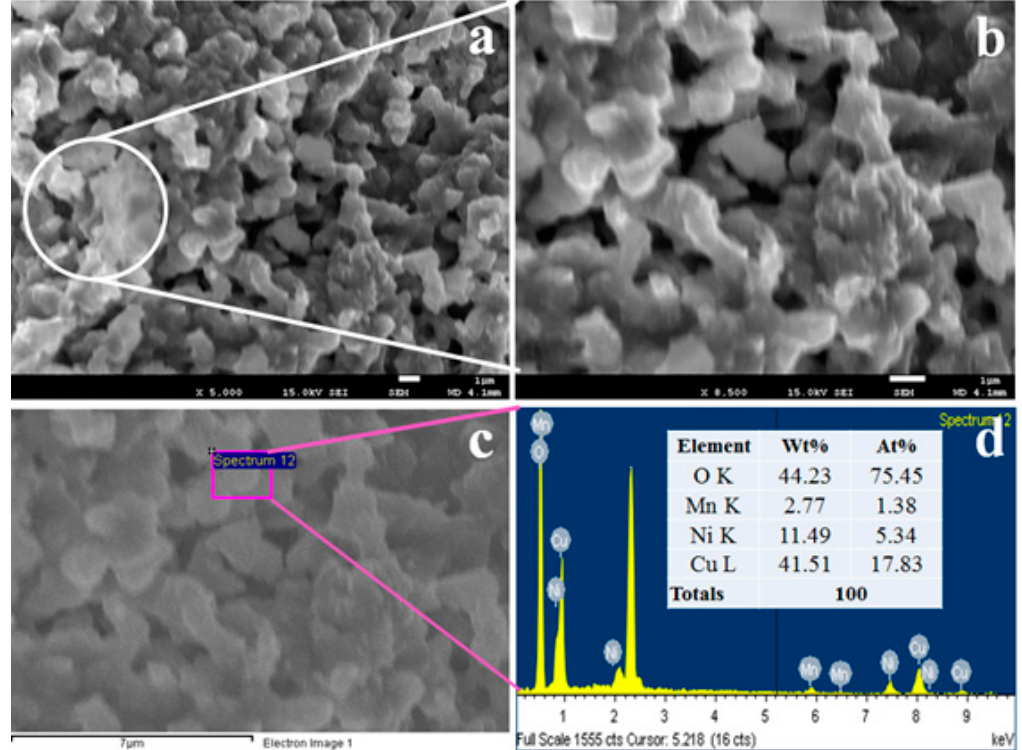
Figure 2. The FESEM and EDS analyses of CMNO nanomaterials. ( a , b ) The structural morphology of synthesized CMNO nanomaterials and ( c , d ) the elemental analysis of prepared CMNO NMs.